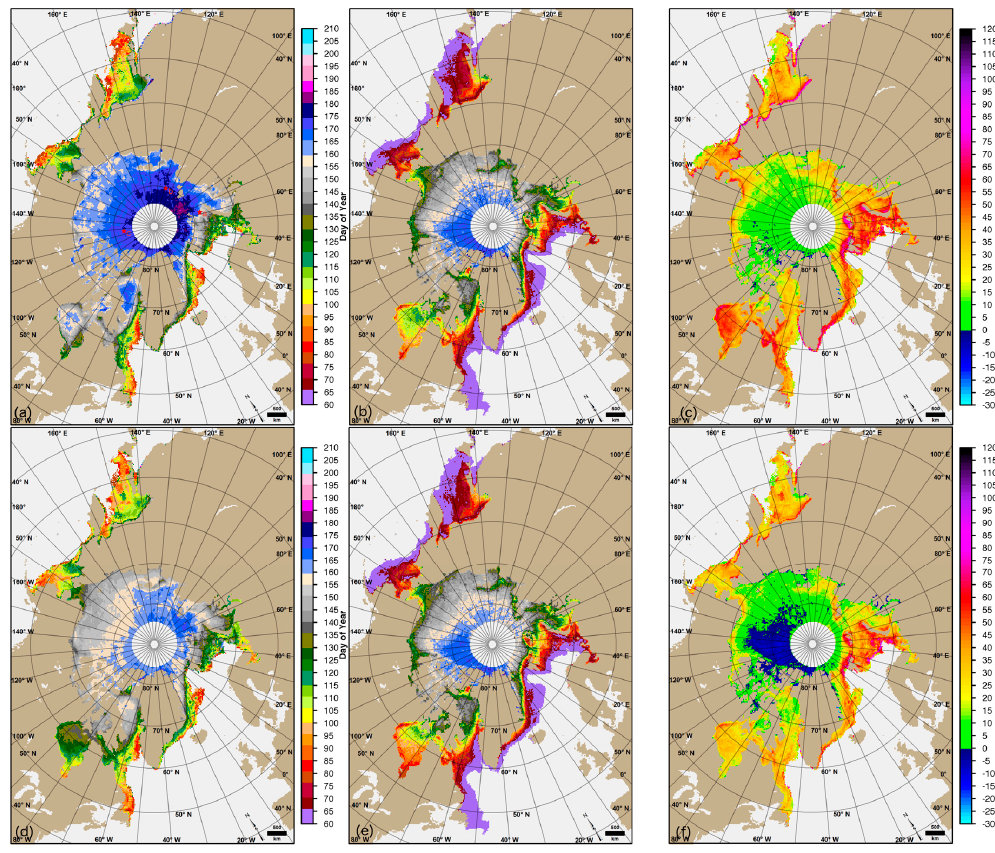
Figure 5. Mean MO dates (1979–2012) for the ( a ) PMWC; ( b ) AHRA; ( d ) PMWC-A; ( e ) AHRA-A;